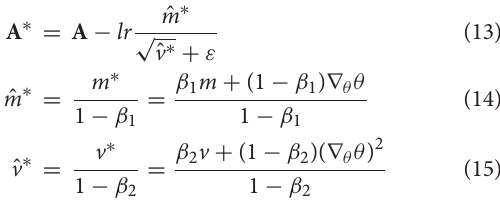
Algorithm 1 summarizes the specific implementation steps of the MDGCN-SRCNN model.